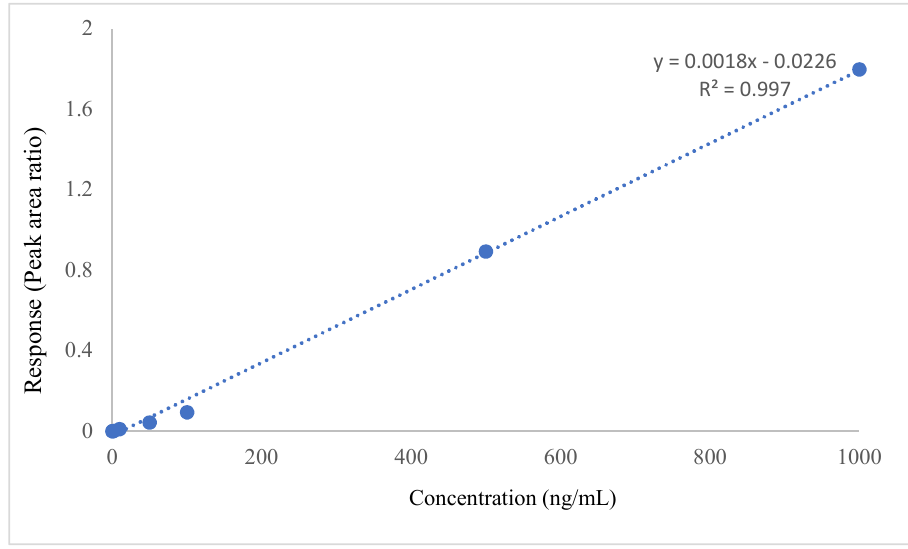
Figure 3. Standard Calibration Curve of Tamatinib.